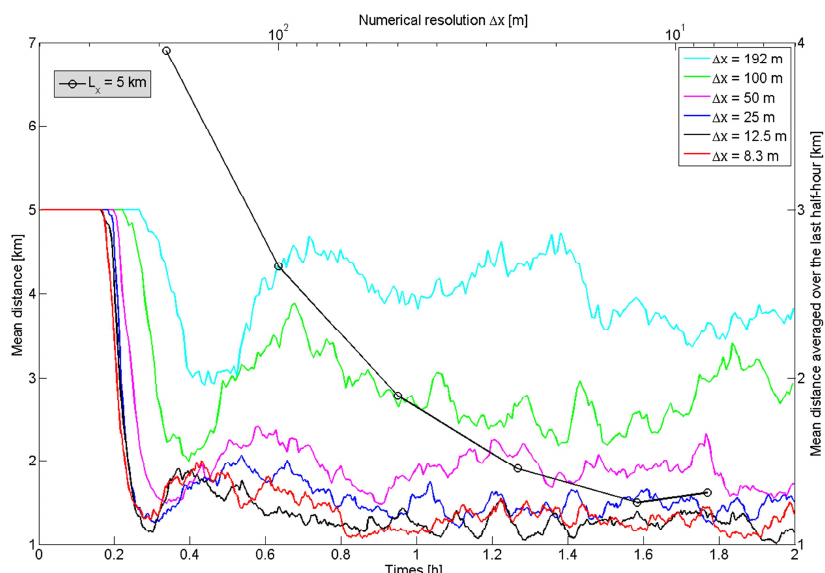
Figure 10. Time series of the mean distance between cloud areas for different horizontal numerical spatial resolutions (coloured lines) with a constant vertical numerical spatial resolution ( 1z = 38 . 5m) and mean distance averaged over the last-half hour of a 2h simulation as a function of numerical spatial resolution (black line with circles). The cumulus cloud is simulated by 3DCLOUD with assimilation of meteorological profiles based on the BOMEX case. Horizontal extensions are L x = L y = 5km and vertical extension is L z = 2700 m.